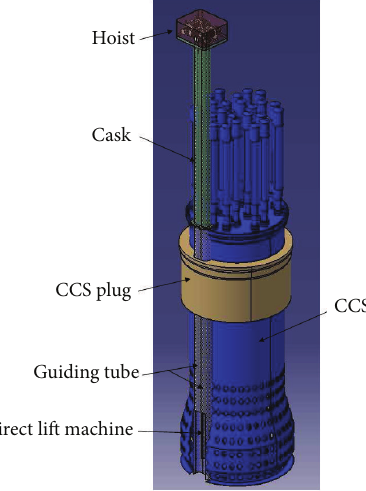
Figure 10: Detail of the fitted direct lift machines.